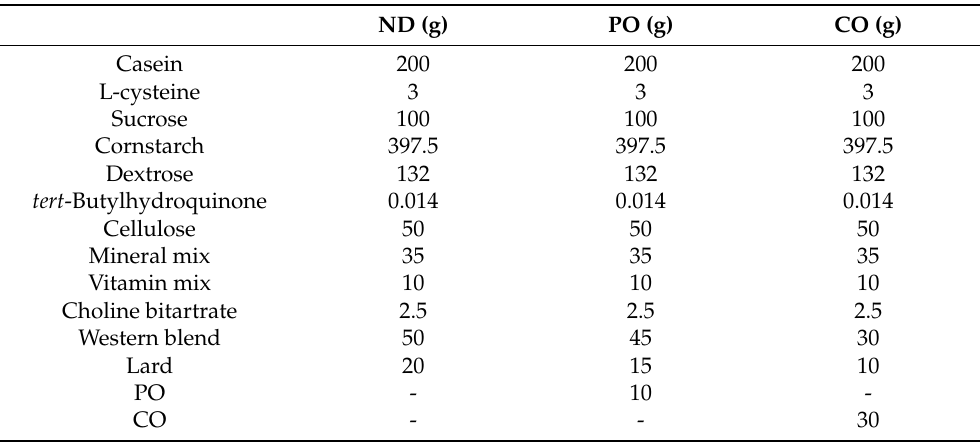
Table 1. Composition of experimental